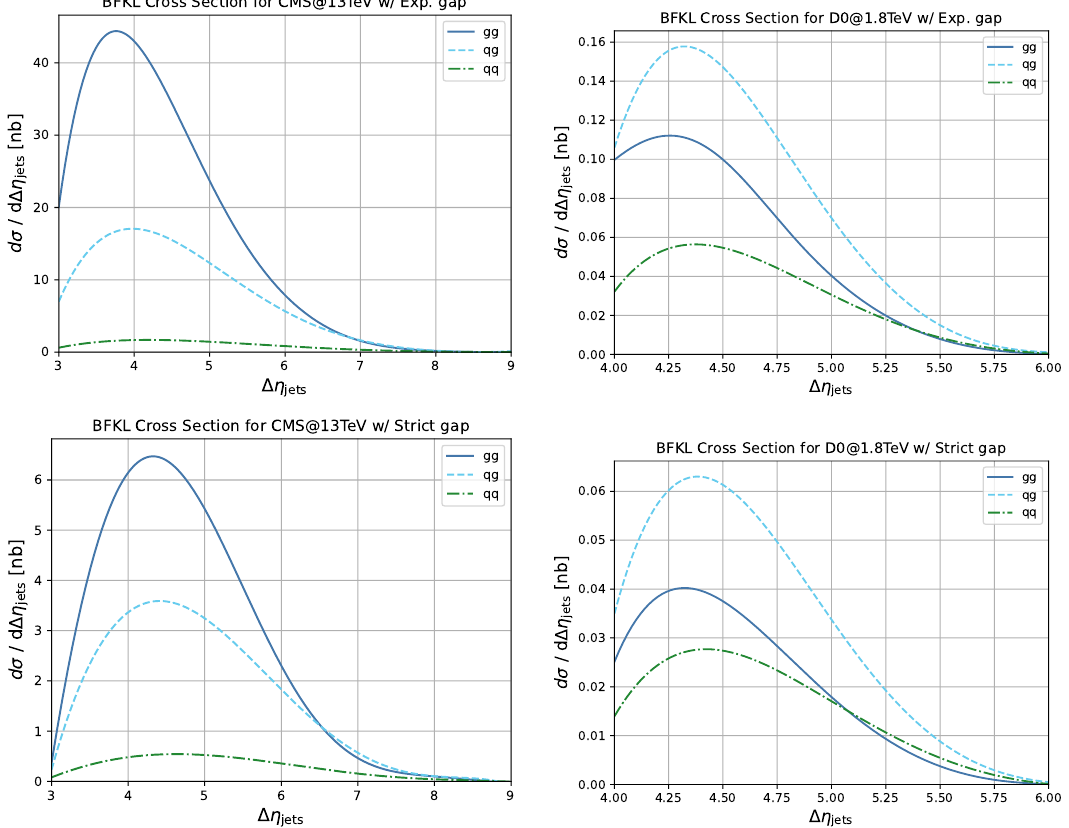
Figure 8 . Differential cross sections as a function of ∆ η jets for CSE dijet events. The plots on the left correspond to the CMS setup at 13 TeV, while the ones on the right correspond to the D0 setup at 1.8 TeV. The lower and upper panels correspond to the strict and experimental gaps, respectively.